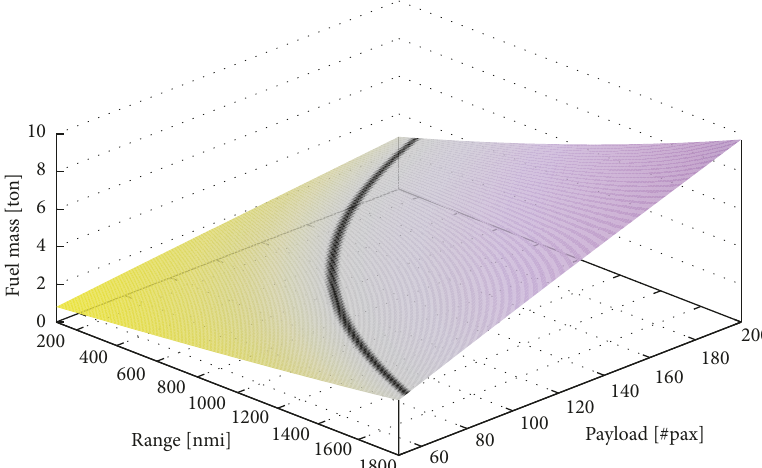
Figure 6: Maximum Take-Off Mass (MTOM) as a function of the design range and the number of passengers related to the regional BWB aircraft for 𝛾 𝐻 = 0 (a): the black line indicates the design solutions characterised by the same amount of fuel burnt as the reference case.